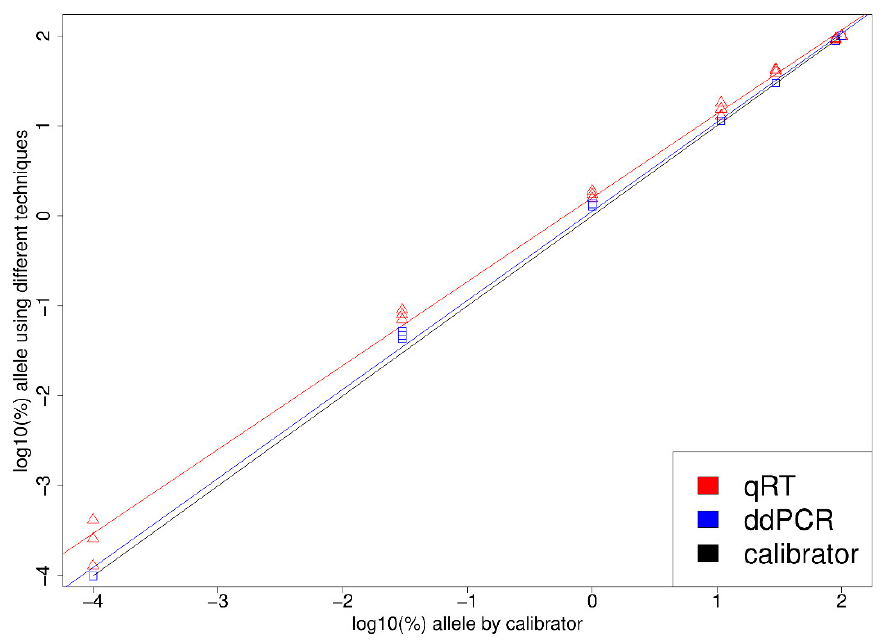
Figure 1. Log–log plot demonstrating the correlation of droplet digital CR (ddPCR) and qPCR JAK2 V617F mutation allele frequency quantification with NIBSC calibrators.